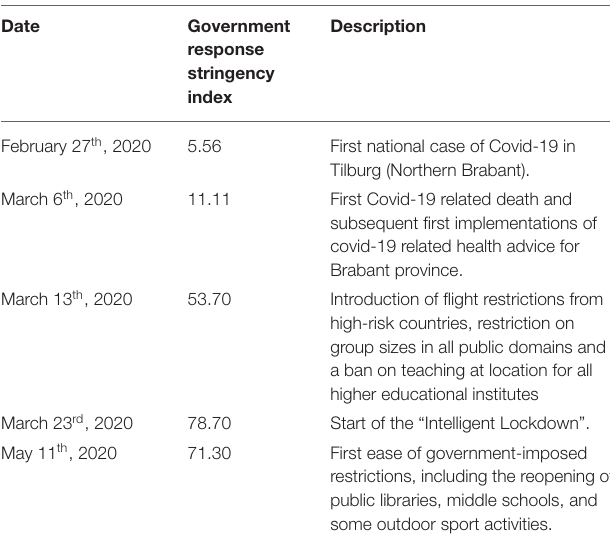
TABLE A1 | Government response stringency Index for the Netherlands with implementation dates of government-imposed restrictions.